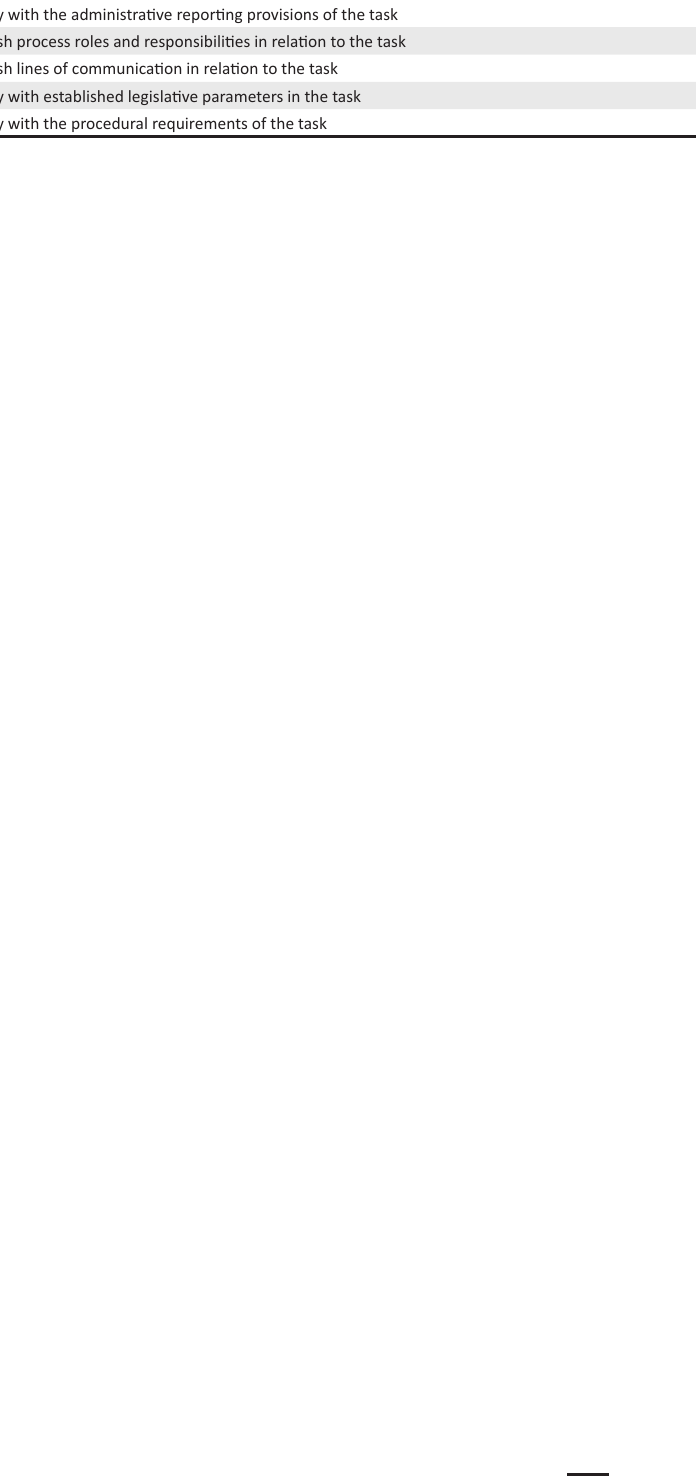
TABLE 1-A1: I use work procedures to…: Compliance 1 2 3 4